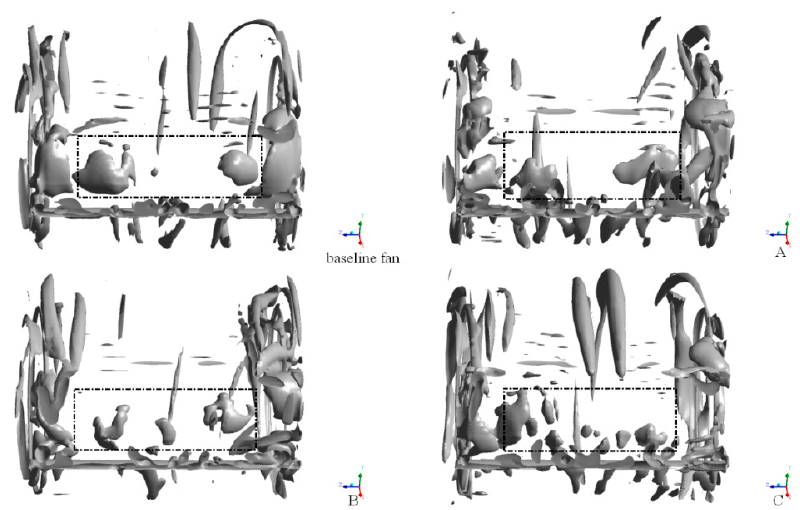
= 1.760: ( A ) model-A; n